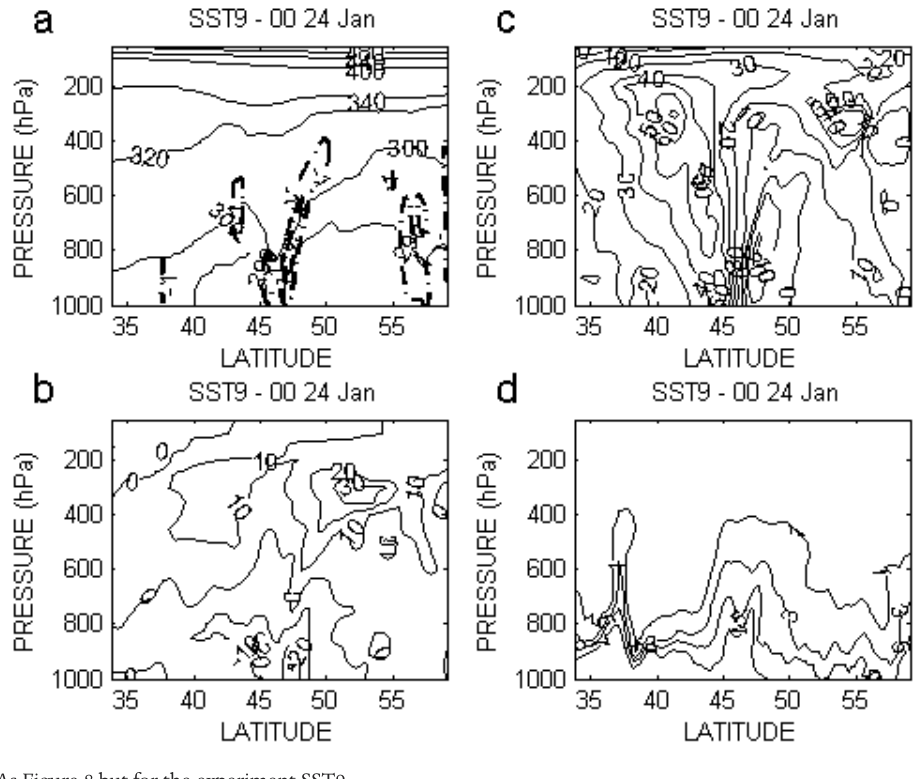
Figure 9. As Figure 8 but for the experiment SST9.